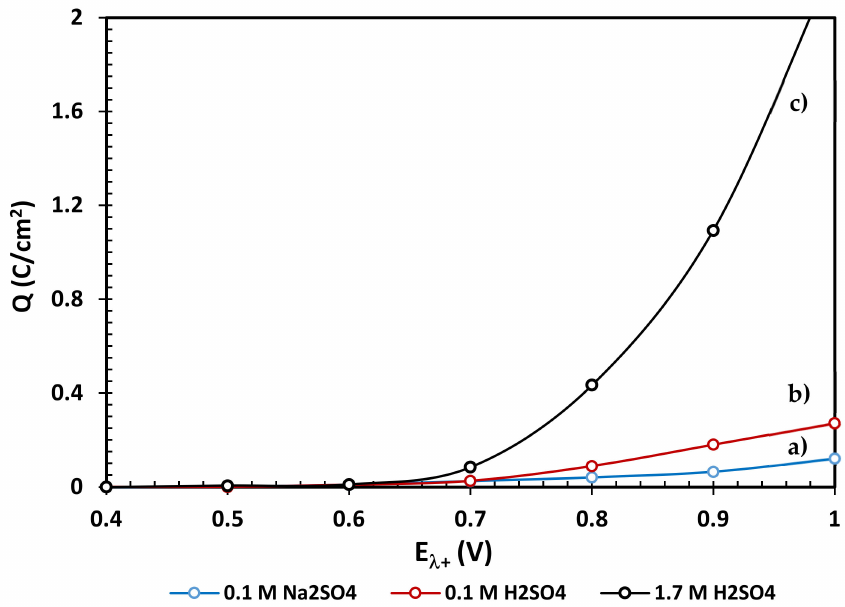
Figure 7. Variation of the voltametric oxidation charge densities of the zinc concentrate EBHSS, as a function of the anodic applied potential, at different pH values, ( a ) 0.1 M Na 2 SO 4 , pH = 7, ( b ) 0.1 M